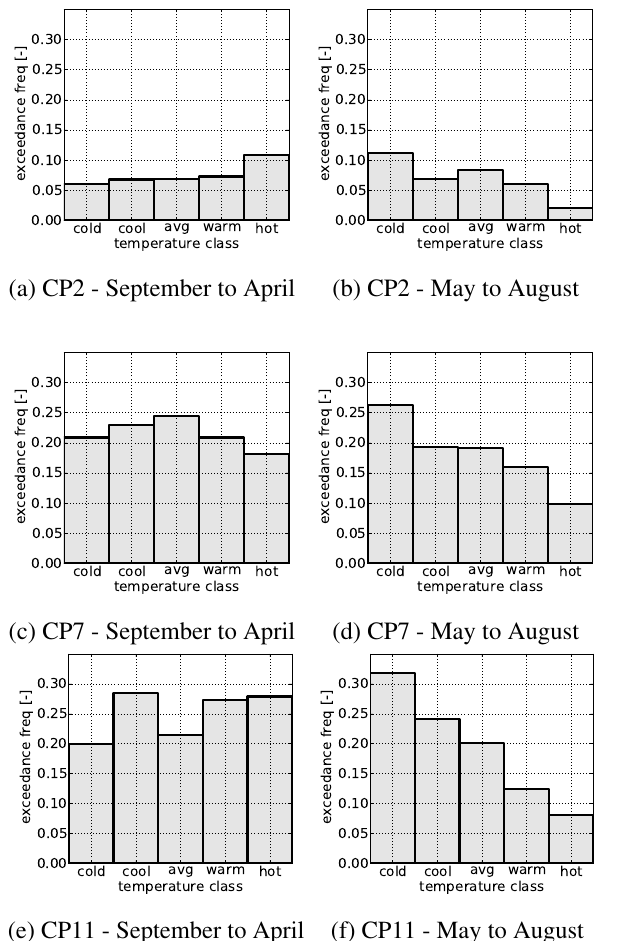
Fig. 6. Frequency of R ≥ 0 . 1 mm according to three different CPs and two seasons